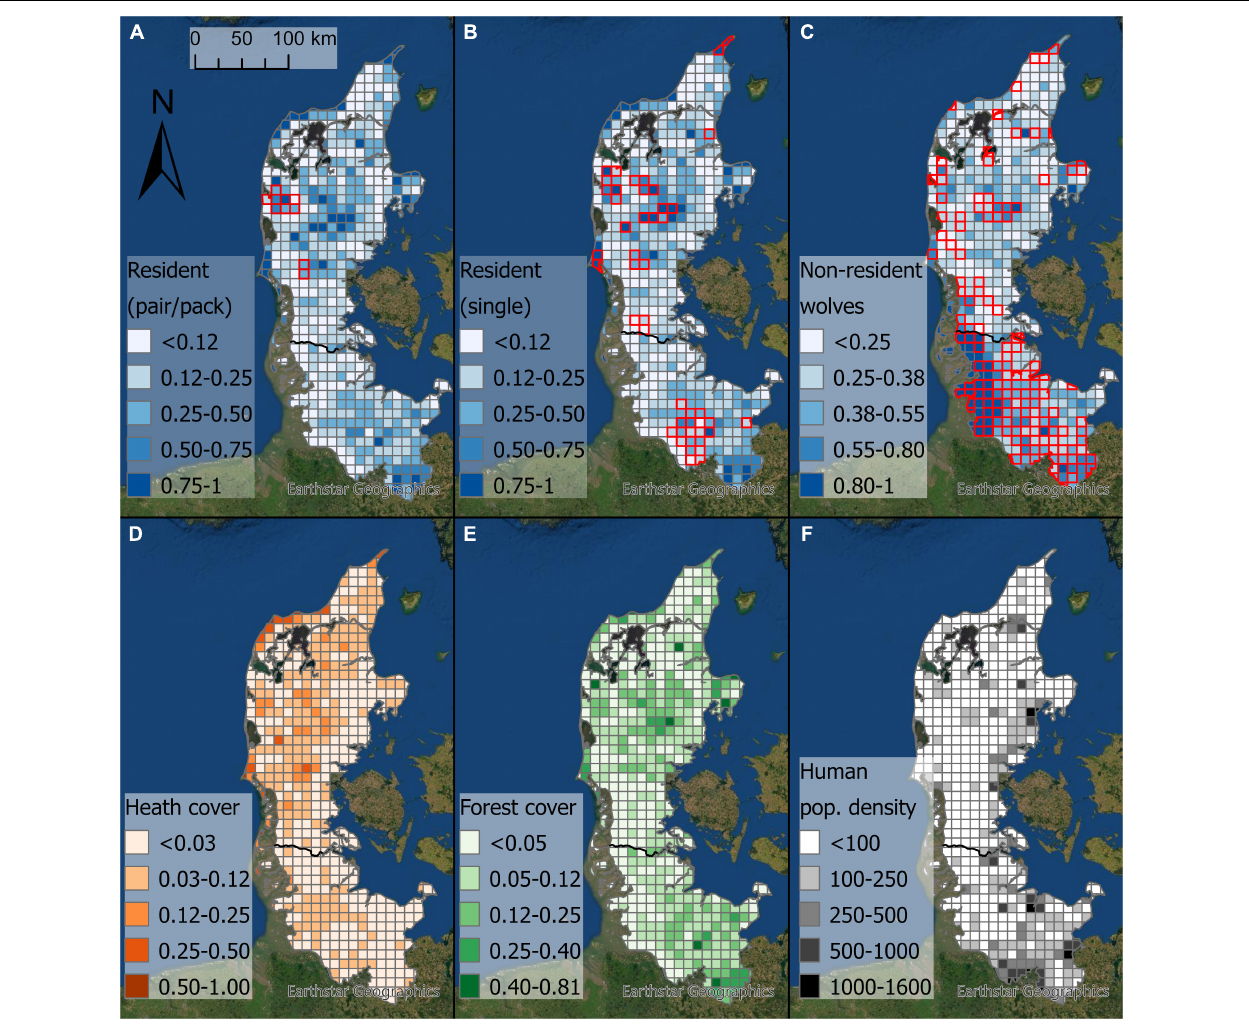
FIGURE 1 | Maps depicting our study area in Jutland separated into 598 grid cells. Red borders show grid cells with observations of (A) resident wolf pairs/packs, (B) single residents, and (C) non-resident wolves. The blue shading depicts the predicted probability of grid cell occupancy by resident wolves [ (A,B) pairs/packs and single residents were merged for the analysis], and non-resident wolves (C) . (D) Proportion of heathland cover (and other non-forested semi-natural areas in SH) per grid cell. (E) Proportion of forest cover per grid cell. (F) Average human population density (people per km 2 ) per grid cell. The black line represents the border between Denmark in the north and Schleswig-Holstein in the